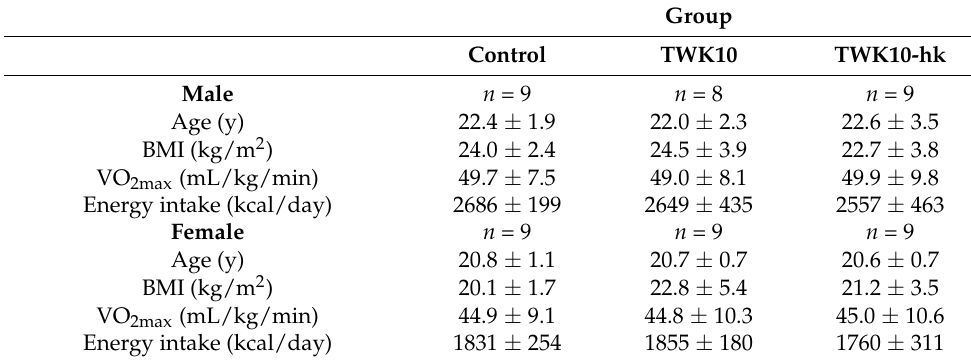
Table 1. Characteristics of study subjects.